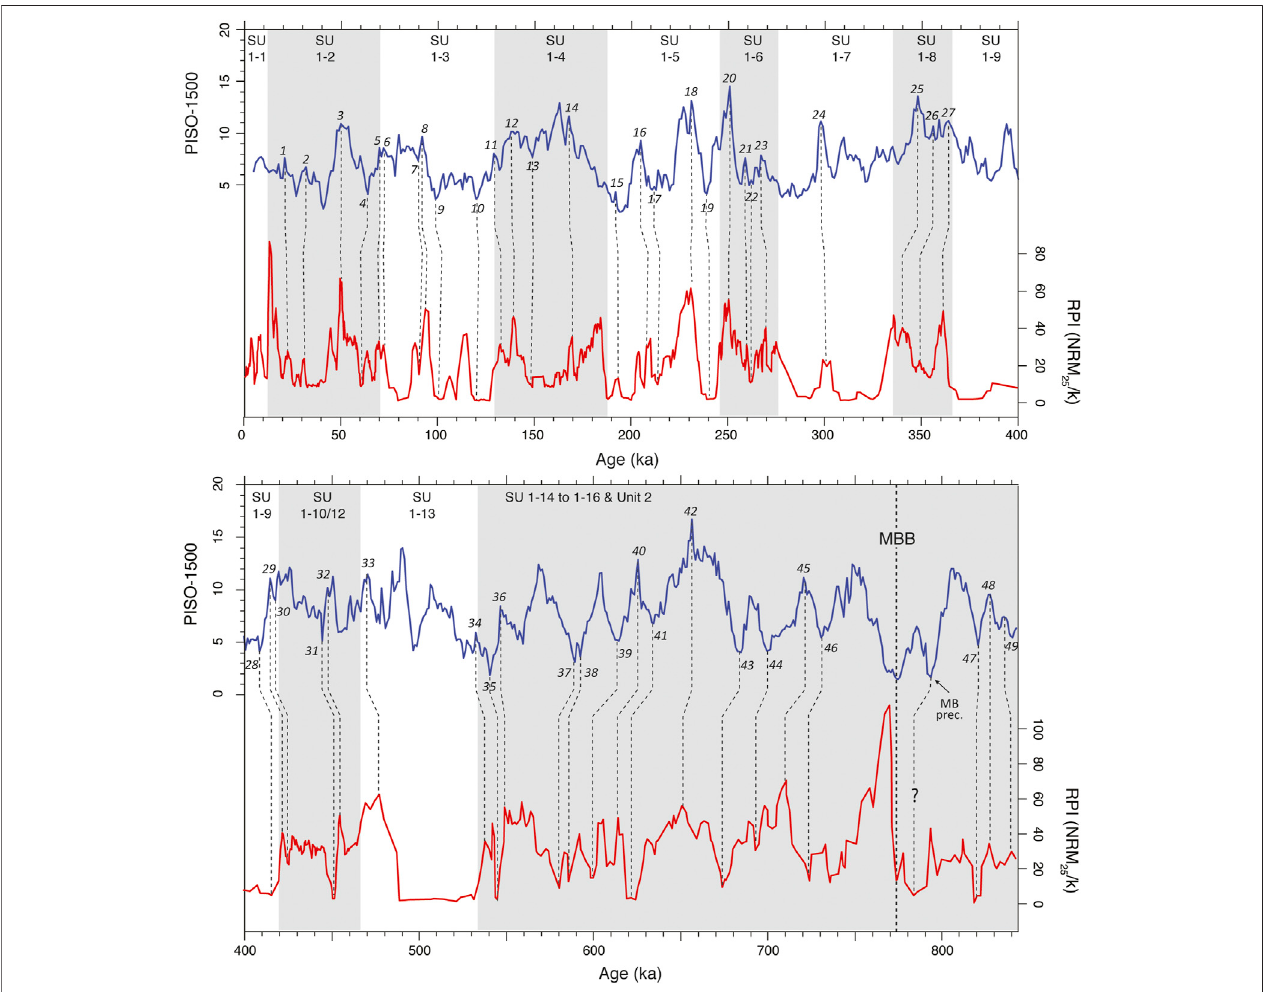
FIGURE7| RPI(NRM 25 / k )forHoleM0079A(redline)comparedtothePISO-1500relativepaleointensitycurve(blueline)byChannelletal.(2009).Numbersnextto the PISO-1500 curve (1 – 49) indicate the peaks that have been correlated. MBB = Matuyama-Brunhes boundary; MB prec. = Matuyama-Brunhes precursor; White and grayshadedareasarethemarineandisolatedintervals,respectively.Thedistributionoftheunitsandsubunitsisindicatedatthetopofeachplot.TheageoftheRPIdata is based on the sea level-calibrated age model of McNeill et al., 2019a. Subunits 1 – 14, 1 – 15, 1 – 16, and Unit 2 are combined in this plot, as the relative boundaries were not used for the age de fi nition of this interval.